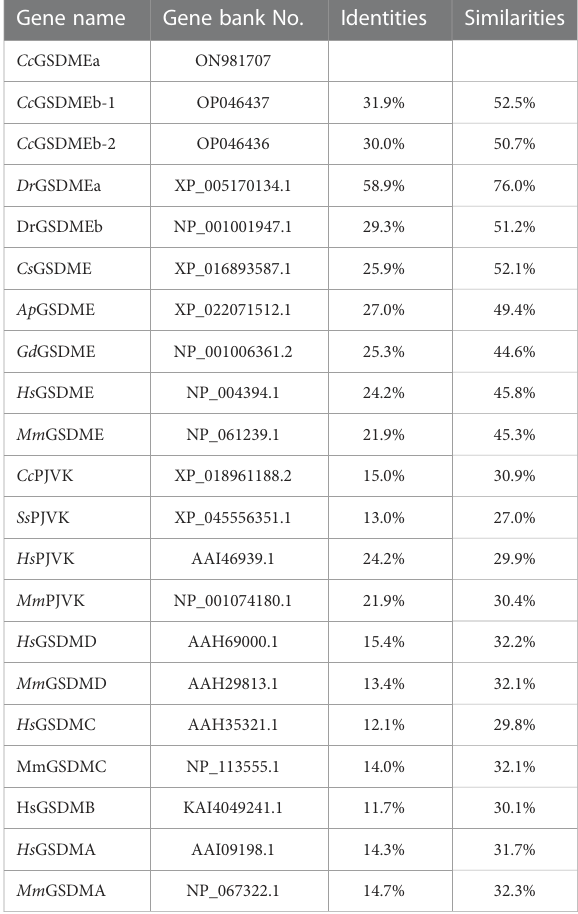
TABLE 3 Identity and similarity between Cc GSDMEa and other species GSDM